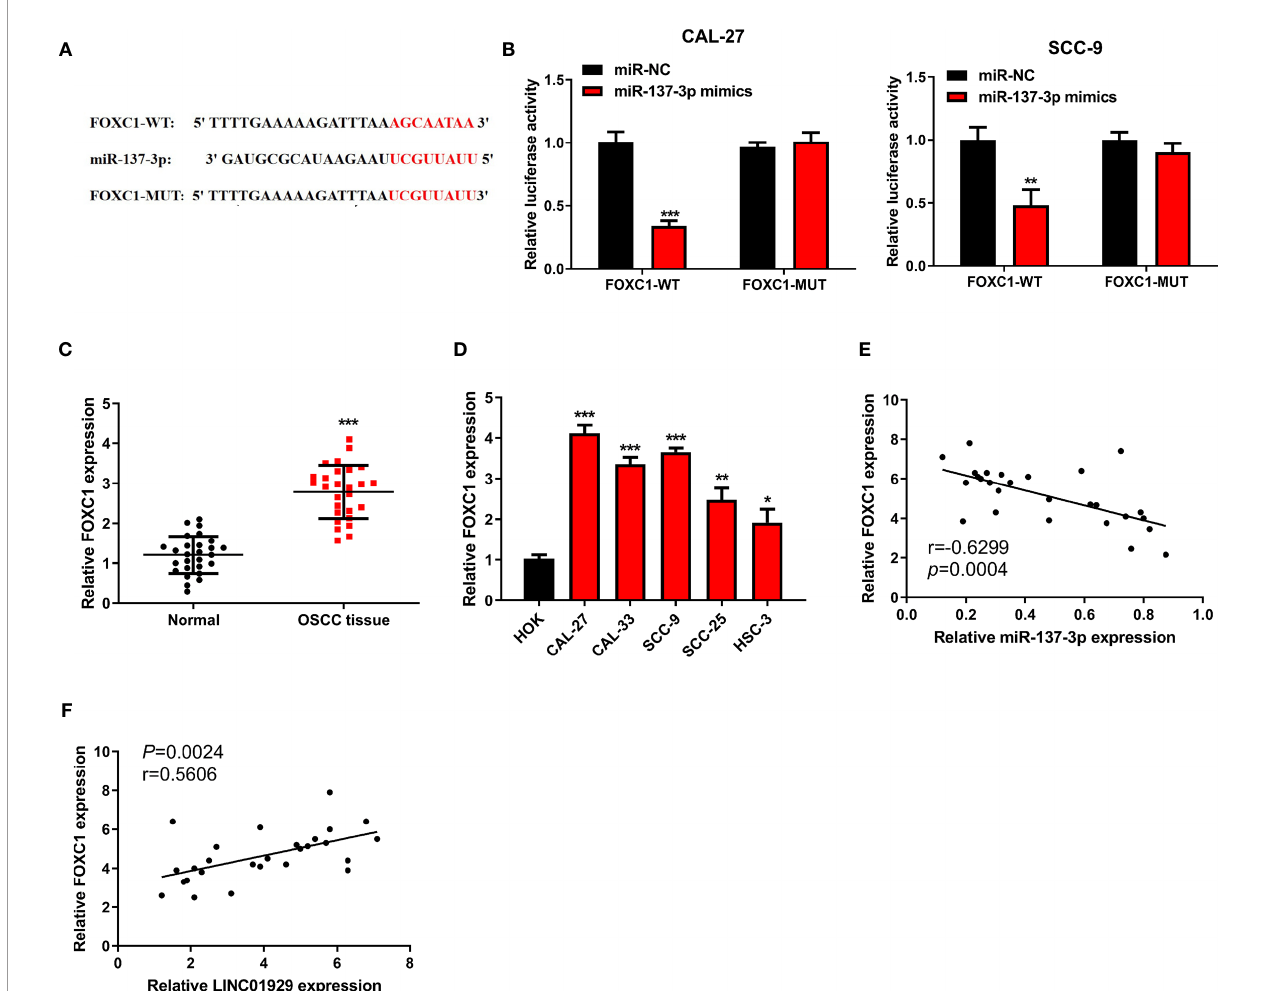
FIGURE 5 | MiR-137-3p directly interacted with FOXC1. (A) Potential binding and mutant sequences were constructed. (B) The putative site of miR-137-3p in the FOXC1 3 ’ UTR was detected by the dual-luciferase reporter assay. (C) FOXC1 expression was monitored by qRT-PCR in OSCC tissues and paired adjacent normal tissues. (D) The FOXC1 expression was measured by qRT-PCR in OSCC cells and the HOKs. (E) Correlation analysis of miR-137-3p expression with FOXC1 expression. (F) Correlation analysis of LINC01929 expression with FOXC1